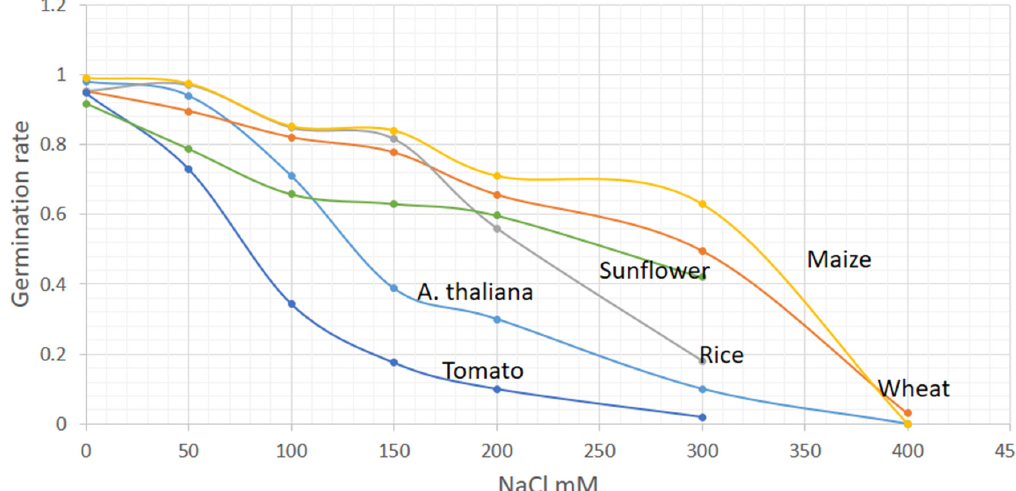
Figure 2. Changes in germination rate of crop plants at different levels of salt stress. Germination rate after 7 days plants grown under different level of NaCl concentration. Data presented for A. thaliana [54–57], wheat ( Triticum aestivum ) [24,47,58,59], rice ( Oryza sativa ) [31,60], maize ( Zea mays ) [46,61,62], tomato ( Solanum lycopersicum ) [63–65], sun flower ( T